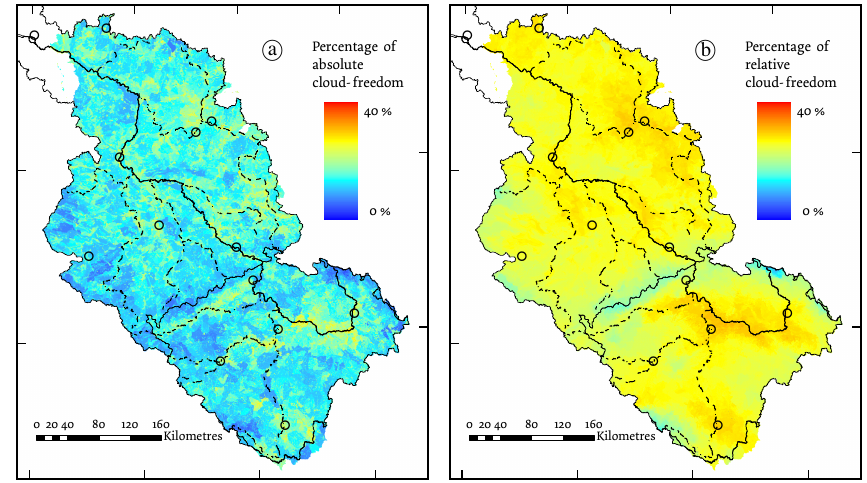
Fig. 7. Percentages of cloud-freedom in hydrotopes, average of 2001–2003. (a) Absolute cloud-freedom: hydrotopes are coloured according to the share of scans in which they were entirely cloud-free, i.e. none of their raster cells were cloud-contaminated. (b) Relative cloud- freedom: mean fraction of cloud-free raster cells within the hydrotope, average of all scans. A legend to the orientation features is displayed in Fig.